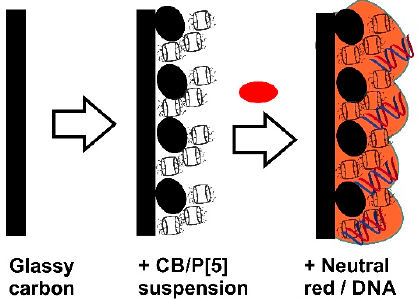
Figure 5. Schematic outline of the deposition of the components and formation of the surface layer by the NR polymerization in the presence of DNA.